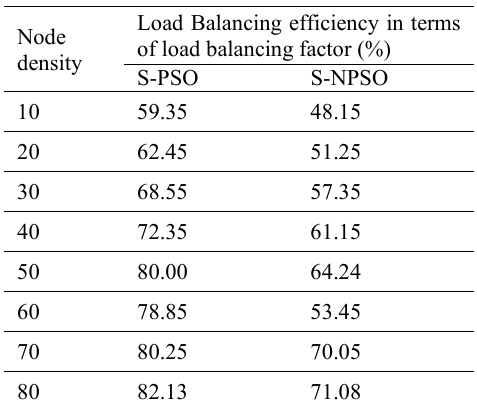
Table 1. Measure of load balancing efficiency